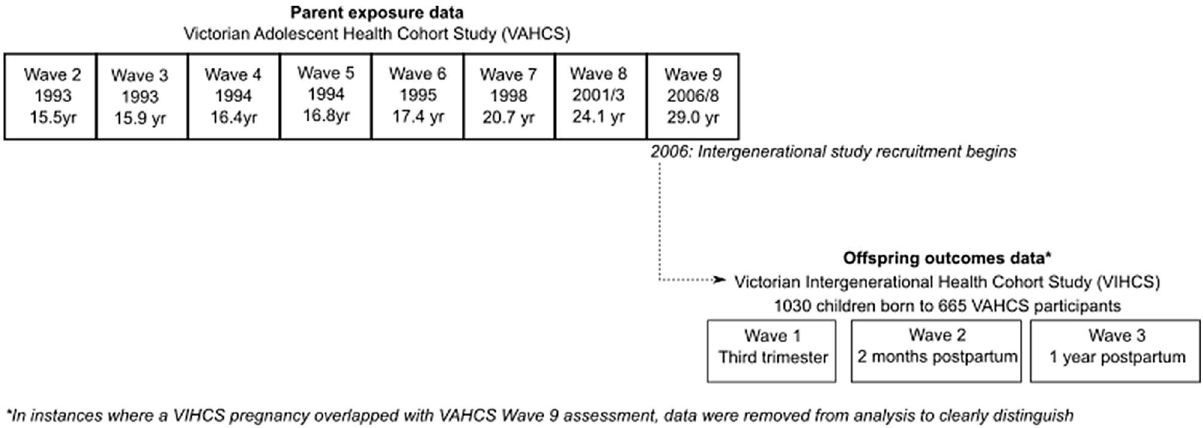
Figure 1. Study design for parent exposure and offspring